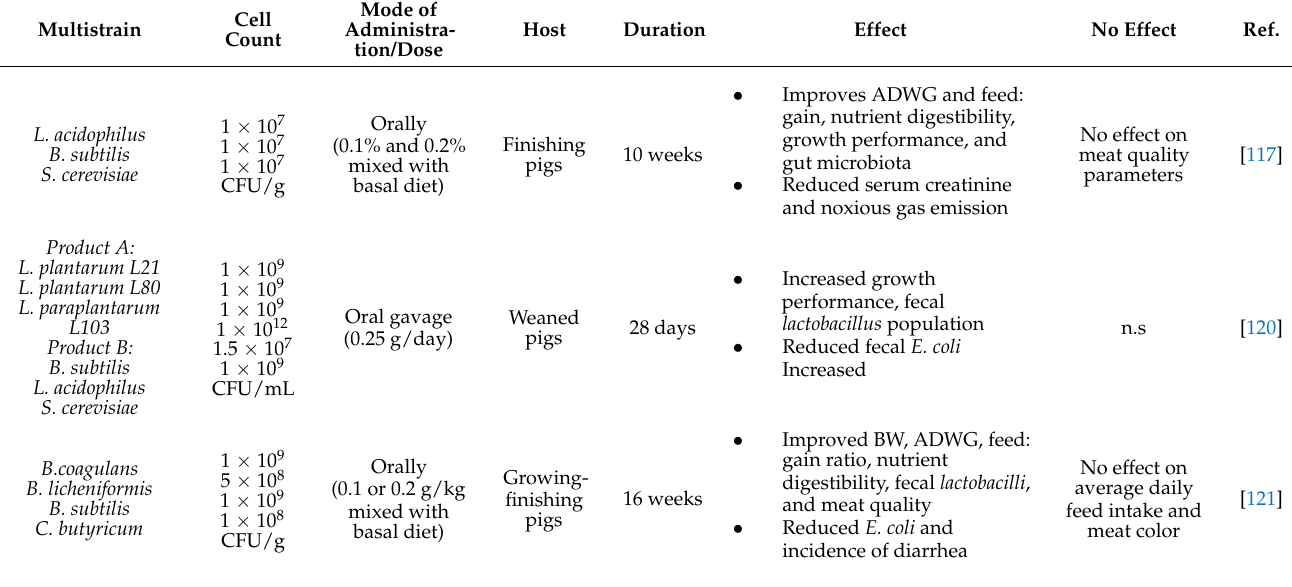
Table 3. Various combinations of multistrain probiotics and their effect on swine